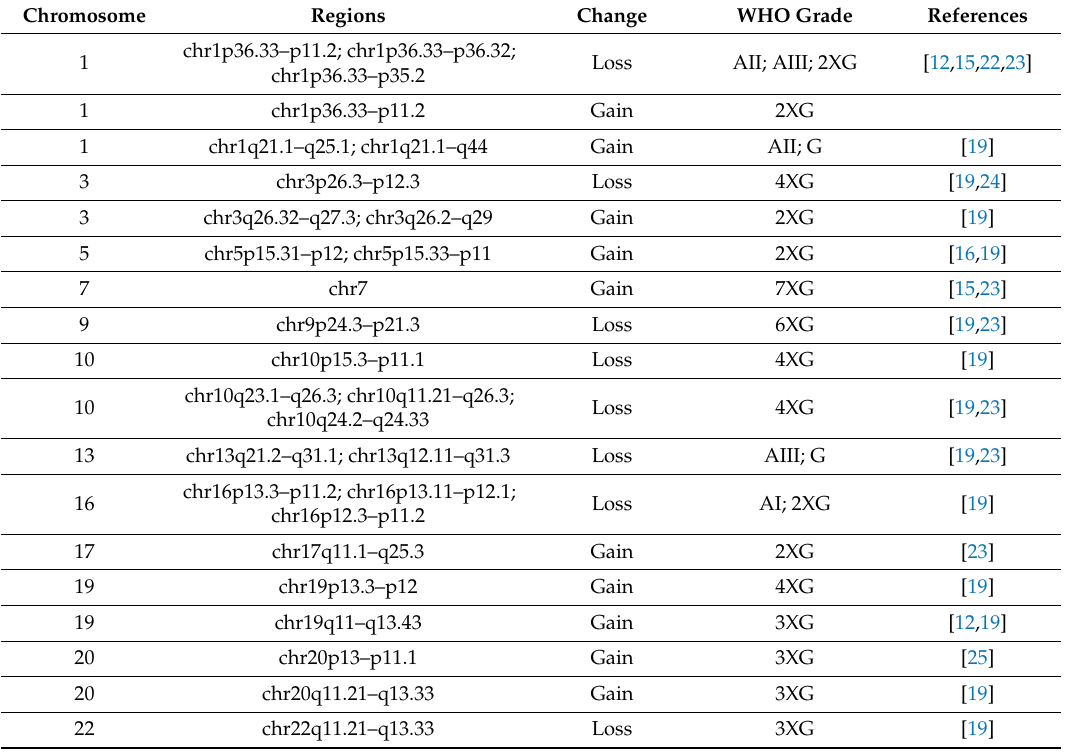
Table 4. The regions showing broad